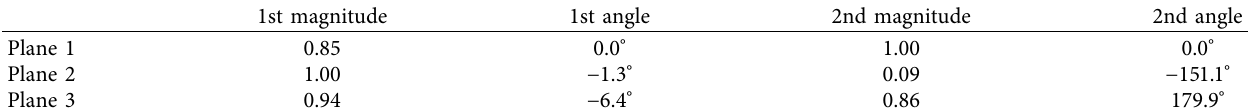
Table 2: Rotor mode shapes normalized by the maximum.